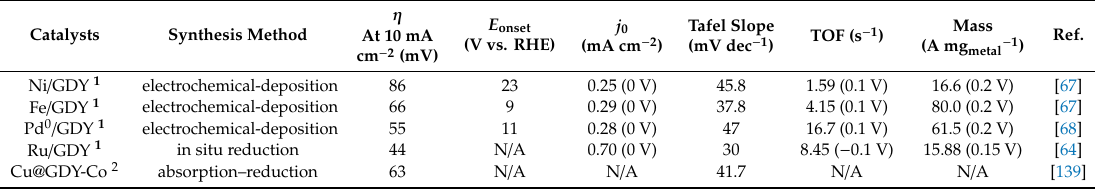
Table 2. HER performance of metal-atom-anchored